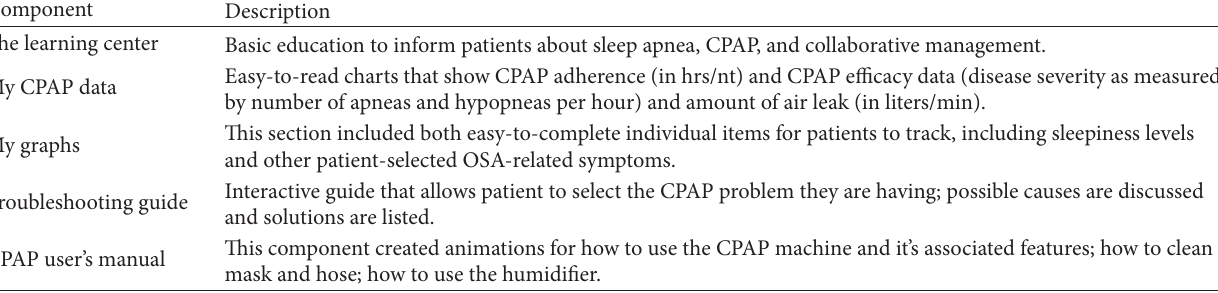
Table 1: Descriptions of the components of the MyCPAP patient